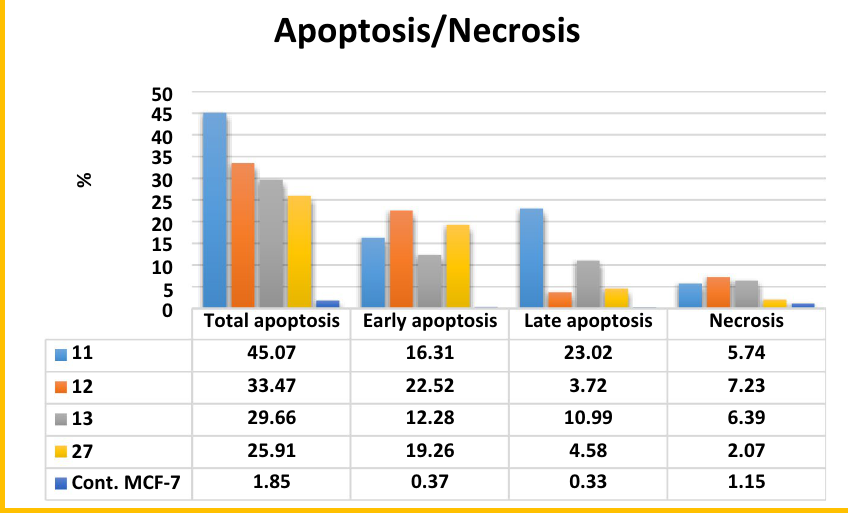
Figure 9. Apoptosis percentage in MCF-7 cells treated with vehicle control and the newly synthesised compounds; 11, 12, 13 and 27.